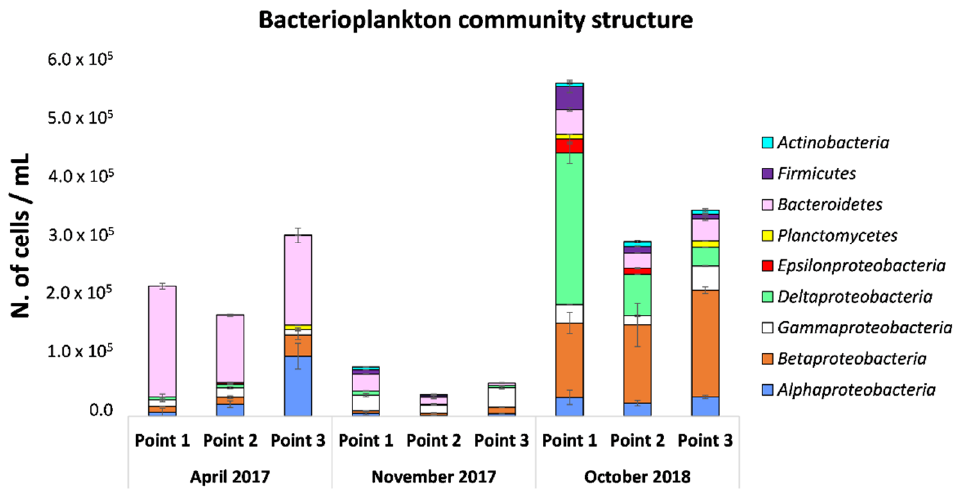
Figure 5. Bacterioplankton characterization (N. of cells/mL) evaluated using Fluorescence In Situ Hybridization at the three sampling points (1, 2 and 3) over the three sampling times (April 2017, November 2017 and October